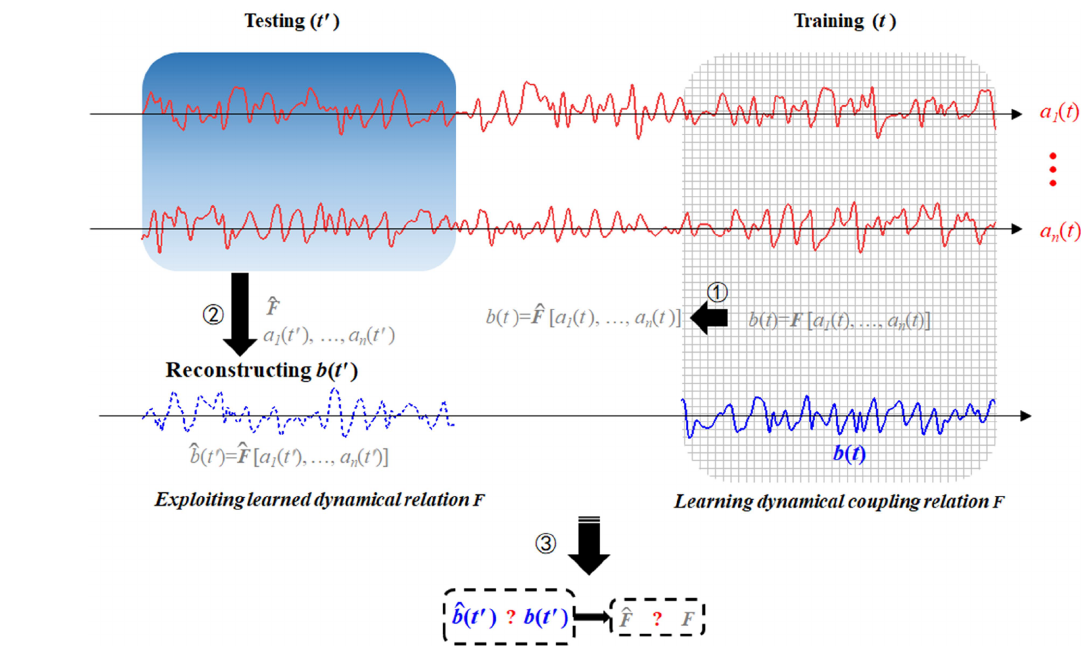
Figure 1. Diagram illustration for reconstructing time series by machine learning. (1) The available part of the dataset { a 1 ( t ), ... , a n ( t ), b ( t ) } is used to train the neural network. F denotes the inherent coupling relation function among the variables a 1 , ... , a n , and b ; ˆ F denotes the inferred coupling relation by neural network. (2) The dataset { a 1 ( t (cid:48) ), a 2 ( t (cid:48) ), ... , a n ( t (cid:48) ) } is input into the trained neural network, and the unknown series, b ( t (cid:48) ), can be reconstructed, denoted as ˆ b ( t (cid:48) ). (3) If ˆ b ( t (cid:48) ) ≈ b ( t (cid:48) ); then, the approximation ˆ F ≈ F can be derived, which indicates that the coupling relation is well